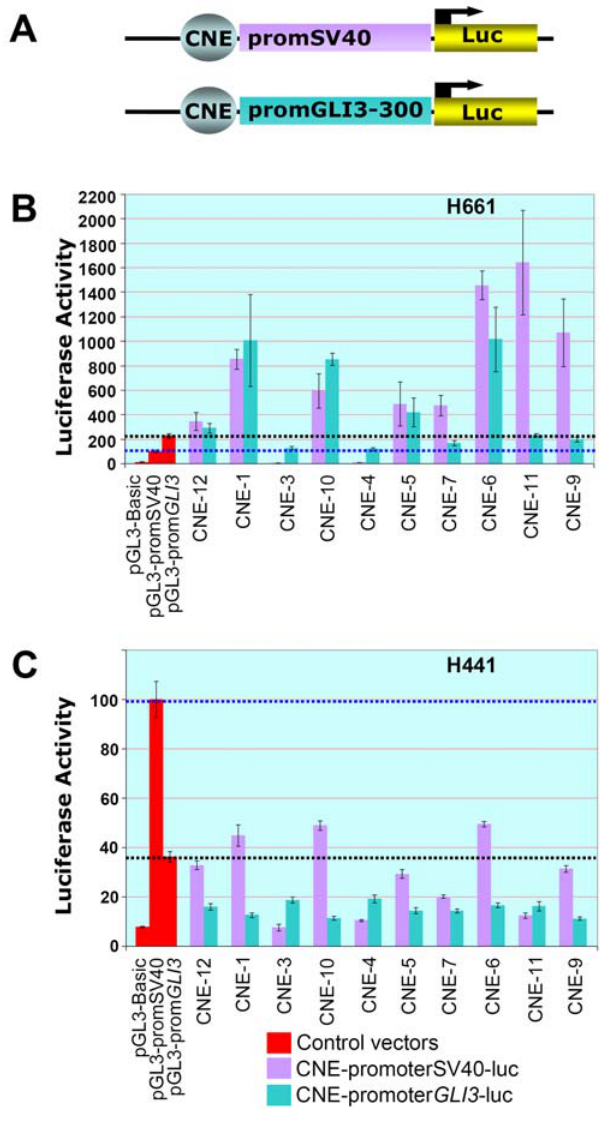
Figure 2. CNEs Regulate Luciferase Reporter Gene Expression in Transiently Transfected Human Cell Lines. (A) Diagrams of the reporter constructs employed to test the regulatory potential of CNEs from the introns of human GLI3 . CNEs were cloned into in a pGL3-Basic vector containing either a minimal GLI3 promoter (pGL3-CNE-prom GLI3 -300- luc) or a heterologous SV40 promoter (pGL3-CNE promSV40-luc) upstream of a firefly luciferase gene. (B) Luciferase activity of reporter constructs in human H661 cells that express endogenous GLI3 . (C) Luciferase activity of reporter constructs in human H441 cells that do not express endogenous GLI3 . The pGL3-Basic vector, with no promoter/enhancer insert was used as a negative control. Luciferase activity in cells transiently transfected with the positive control, a construct containing a SV40 promoter upstream of the reporter gene (pGL3-promSV40-luc), was taken as 100% (blue dotted line). A plasmid expressing Renilla luciferase was co-transfected as a standard for transcription efficiency. Average firefly luciferase reporter activities relative to Renilla luciferase activity from three triplicate transfection experiments are depicted as percentage of activity obtained with the positive control vector (B, C). Standard errors of the mean are shown. Black dotted lines indicate the luciferase expression level reached in each cell line with the pGL3-prom GLI3 -300-luc vector.